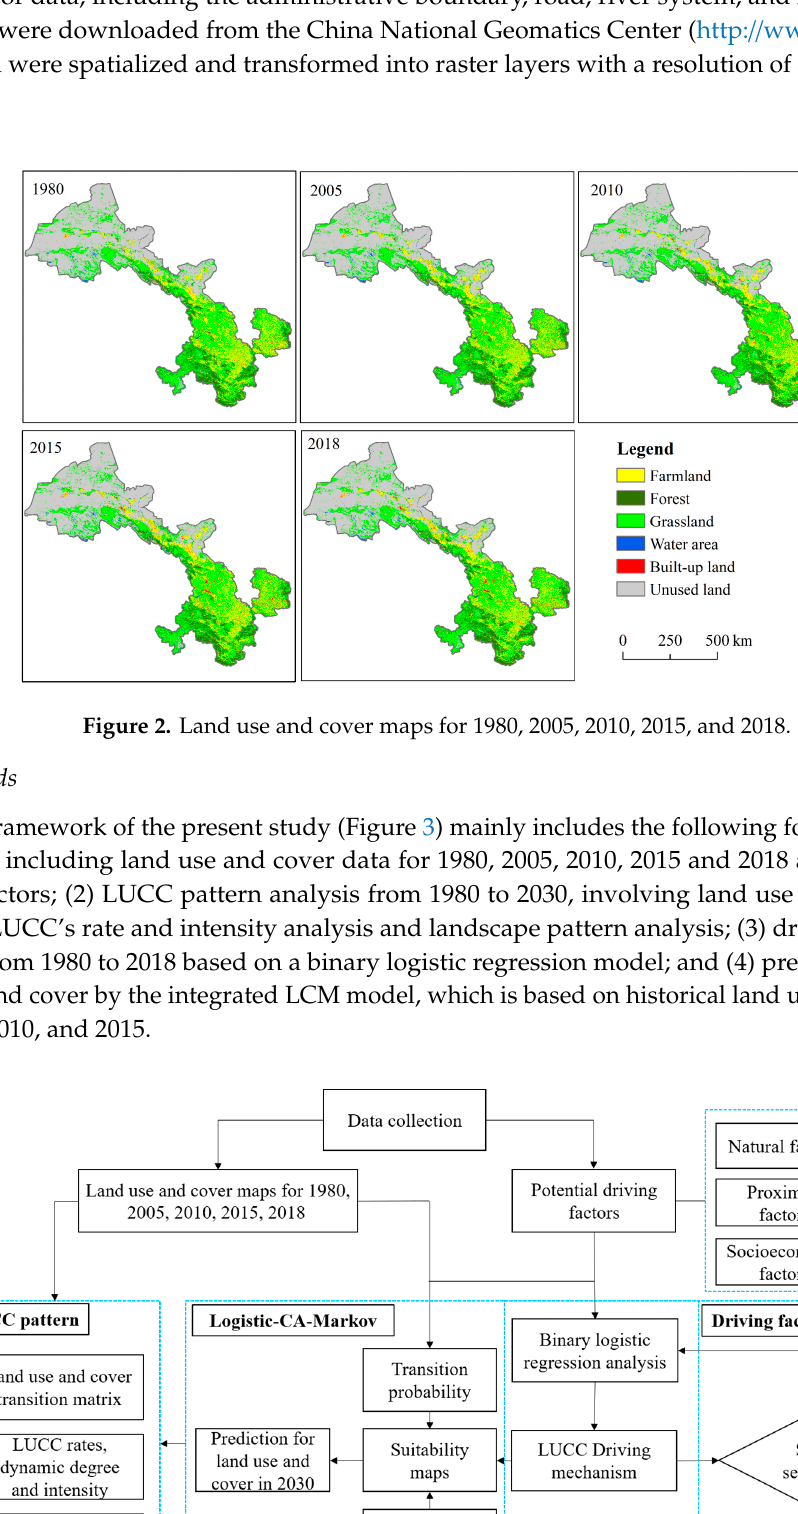
Figure 3. Framework building for the present study.